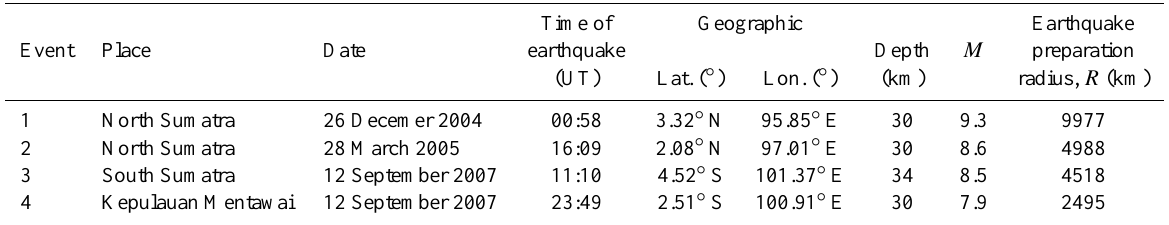
Table 1. The occurrence time, geographic coordinates, depth, magnitude and earthquake preparation radius of large earthquake events in Sumatra (http://earthquake.usgs.gov). Time of Geographic Earthquake Event Place Date earthquake Depth M preparation (UT) Lat. ( ◦ ) Lon. ( ◦ ) (km) radius, R (km) 1 North Sumatra 26 Decemer 2004 00:58 North